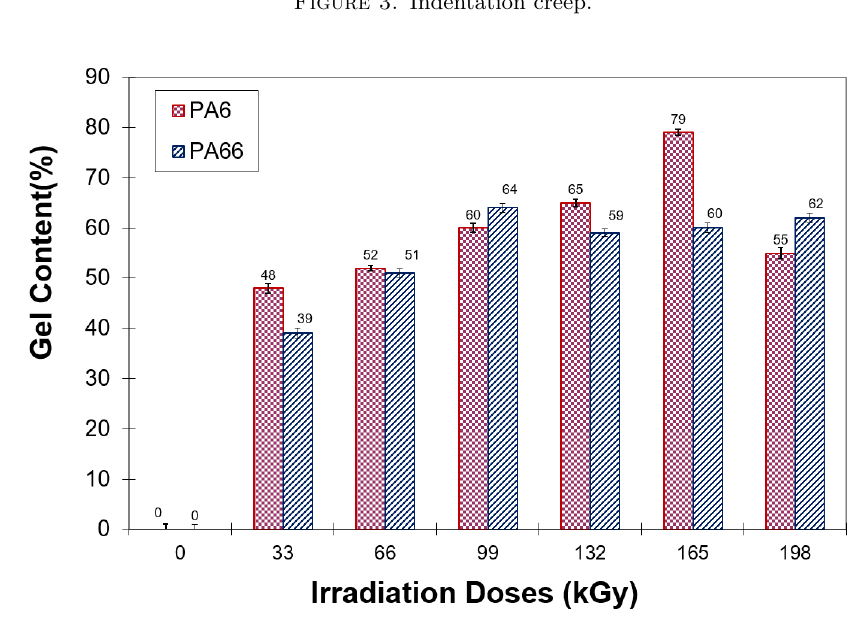
Figure 4. Gel content.